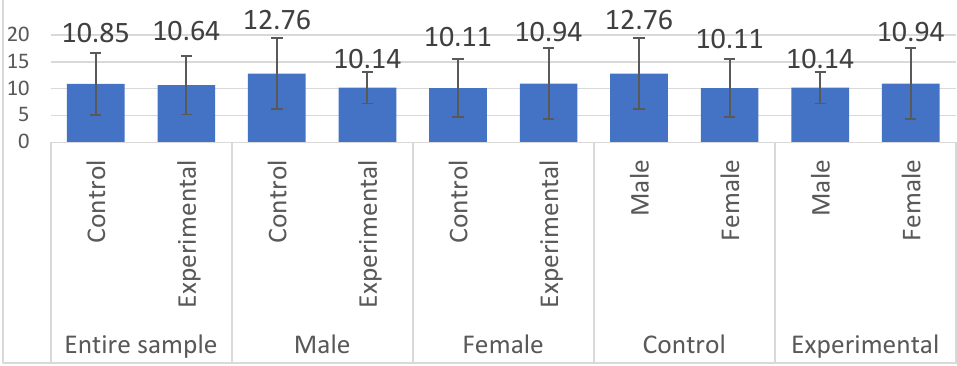
Figure 1. Mean Differences Between Groups and Genders in the Pretest.